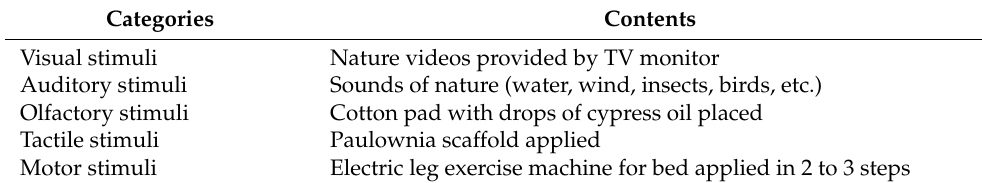
Table 2. Five types of indirect forest